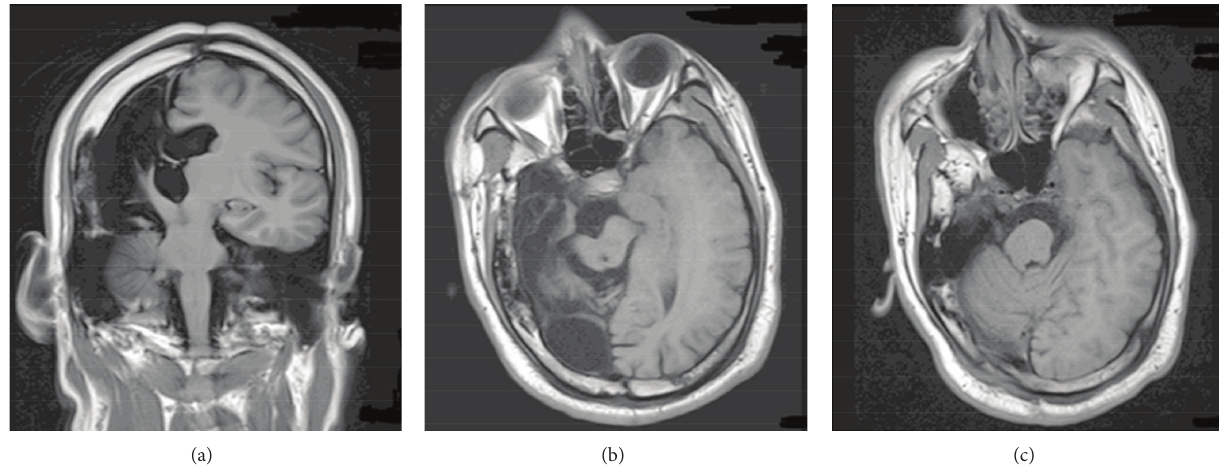
Figure 1: A coronal slice (a) and two axial slices through the midbrain (b) and pons (c) in patient 5. Marked atrophy of the basal nuclei, thalamus, midbrain, and pons ipsilateral to hemispherectomy is